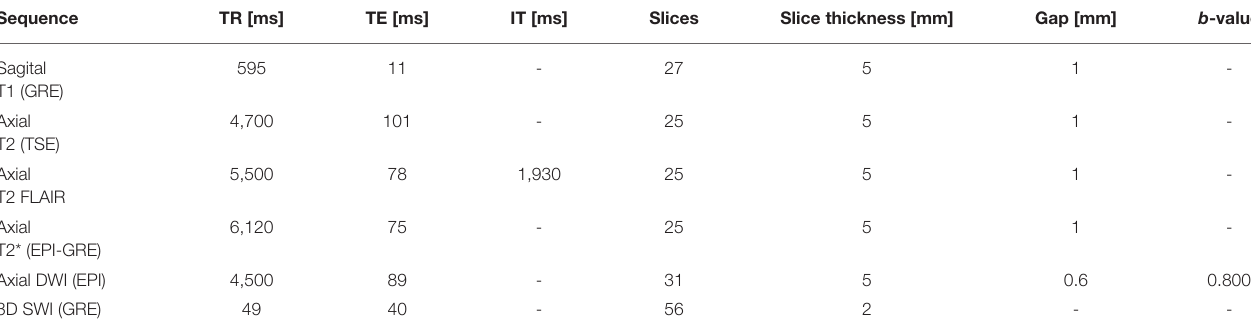
GRE, gradient recalled echo; TSE, turbo spin echo; FLAIR, fluid-attenuated inversion recovery; EPI, echo-planar imaging; DWI, diffusion-weighted imaging; SWI, susceptibility-weighted imaging.